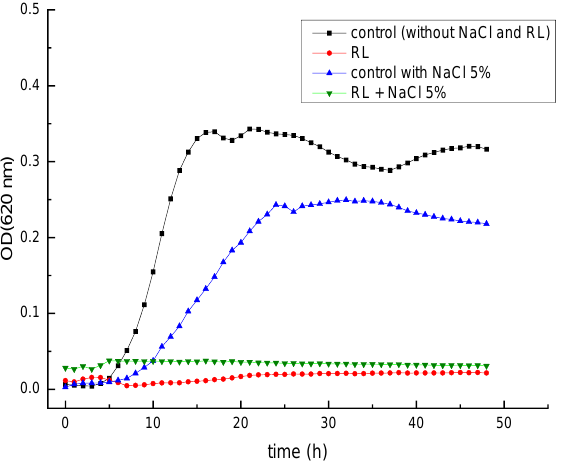
Figure 6. Growth kinetics of L. monocytogenes Scott A in BHI medium at pH 5.0 with and without the addition of 500 µg/mL of RL and 5% NaCl at 30 °C. Data points represent the mean values of three replicates. Error bars have been omitted for clarity.